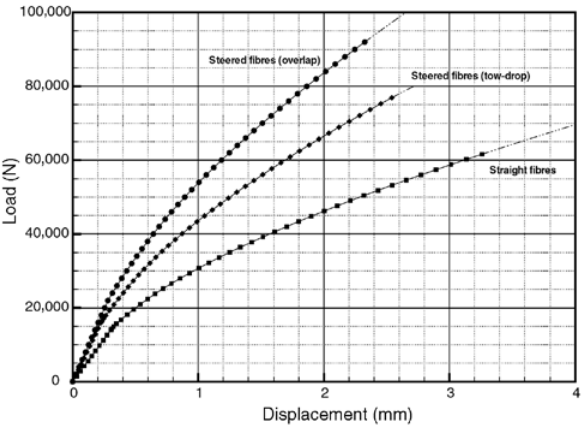
Figure 4: Load-displacement curves for panels designed by three different construction methods. First-ply failure is indicated by the last symbol on each curve. Repro- duced from Lopes et al. [37].